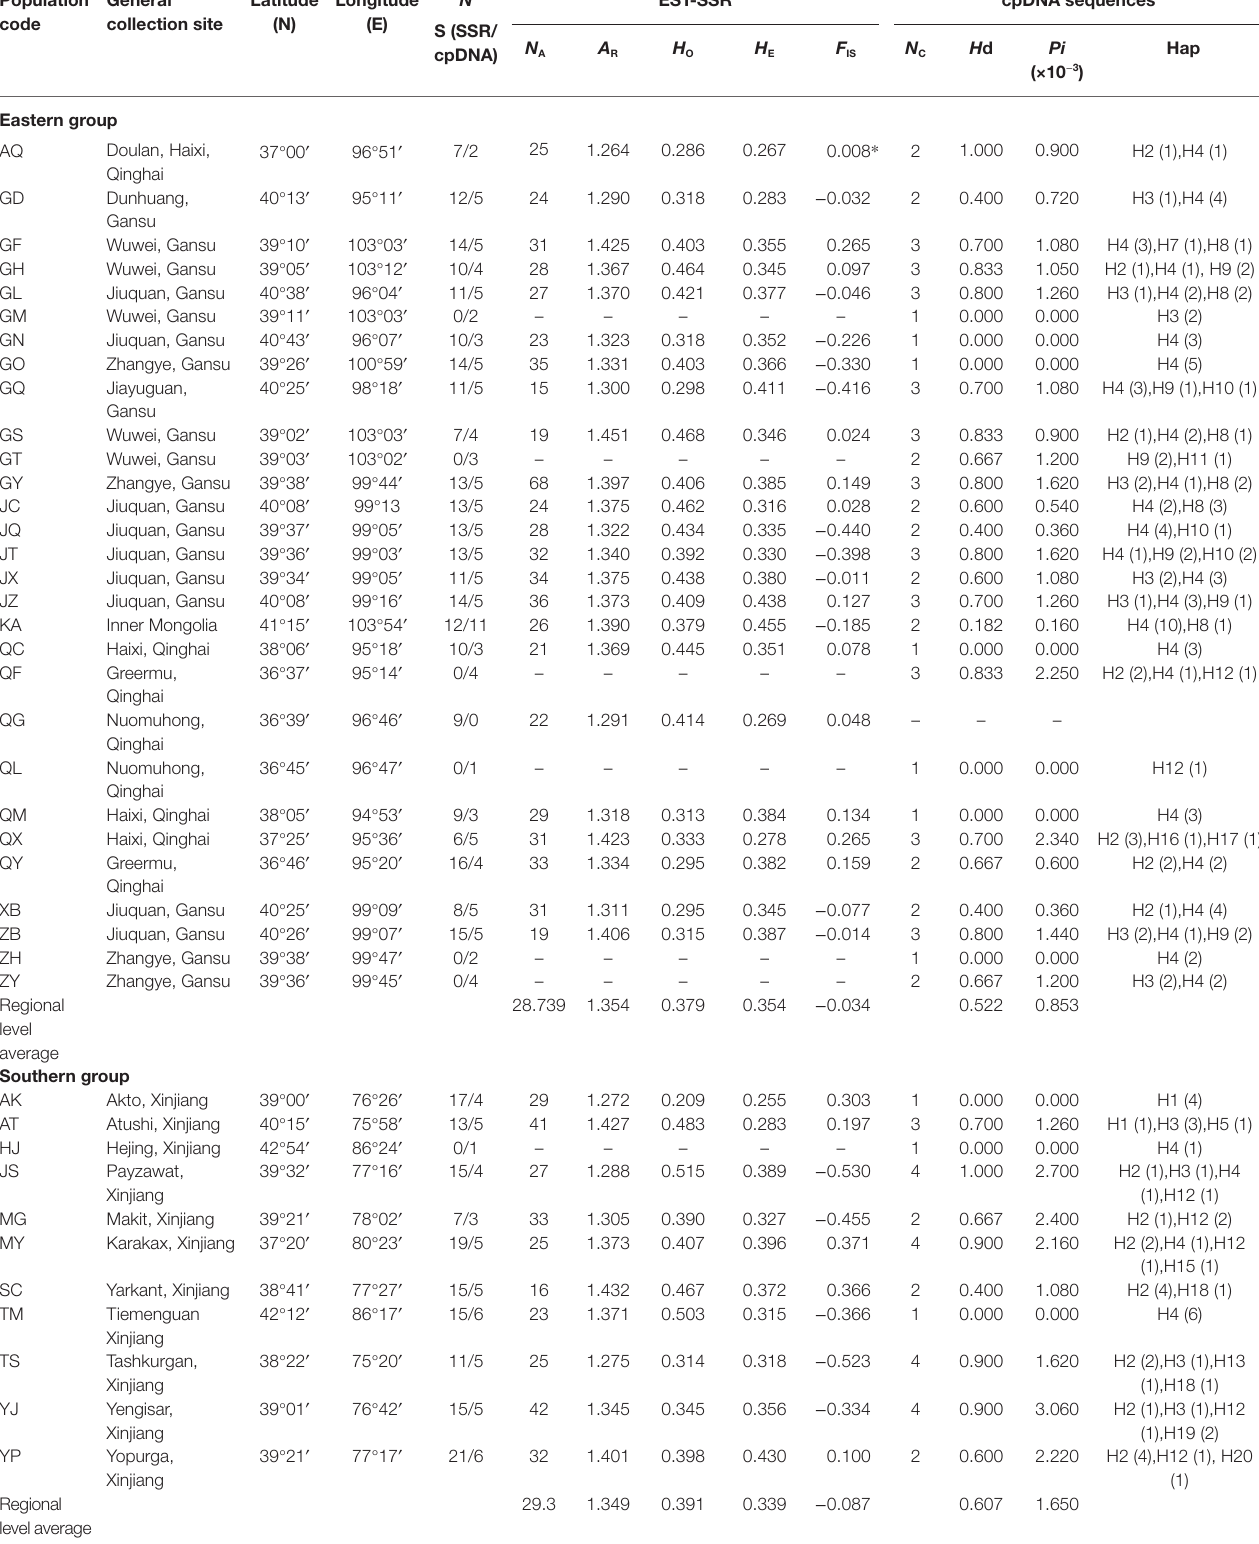
TABLE 1 | Details of sample localities for the 50 Lycium ruthenicum populations studied. Population General code collection